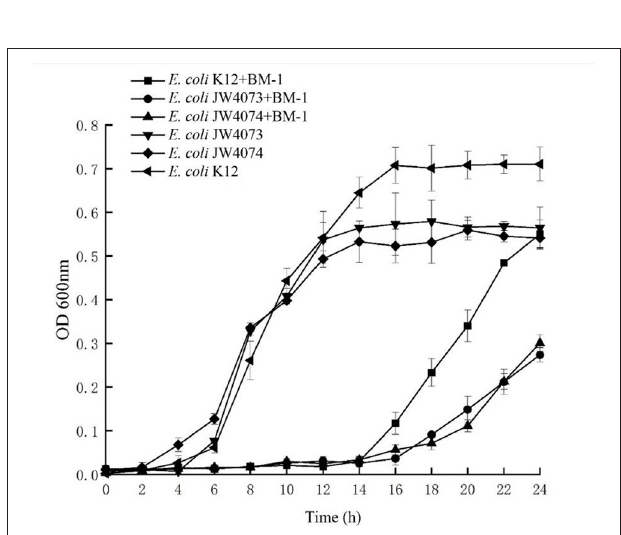
FIGURE 7 | Effect of plantaricin BM-1 on the growth of wild type E. coli K12, E. coli JW4073, and E. coli JW4074. (cid:4) , • and N represent the OD 600 of wild type E. coli K12, E. coli JW4073, and E. coli JW4074 in the presence of plantaricin BM-1 (3 × MIC), respectively. ◭ , H and (cid:7) represent the OD 600